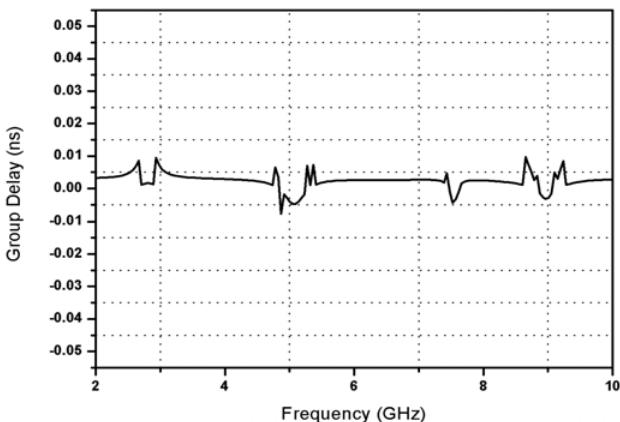
Figure 12: Group delay for the proposed octagonal ring shape wideband